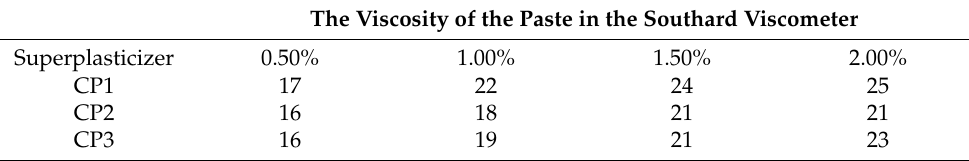
Table 6. The viscosity of the paste in the Southard viscometer. The Viscosity of the Paste in the Southard